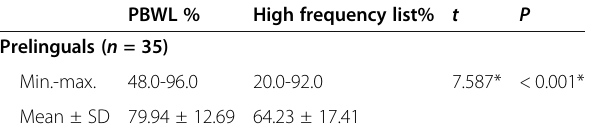
Table 4 Comparison between PBWL scores and high frequency words discrimination scores for postlingual group ( n =